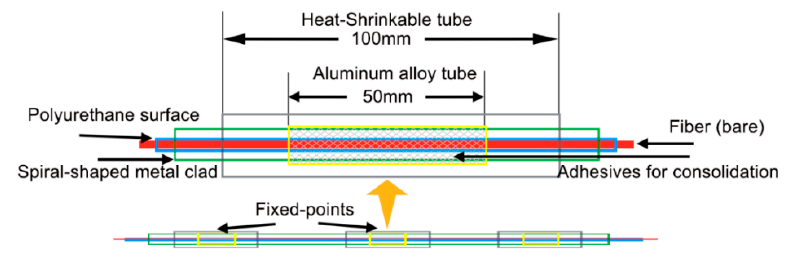
Figure 12. Fixed-point distributed optical fiber sensor for earth fissure monitoring.